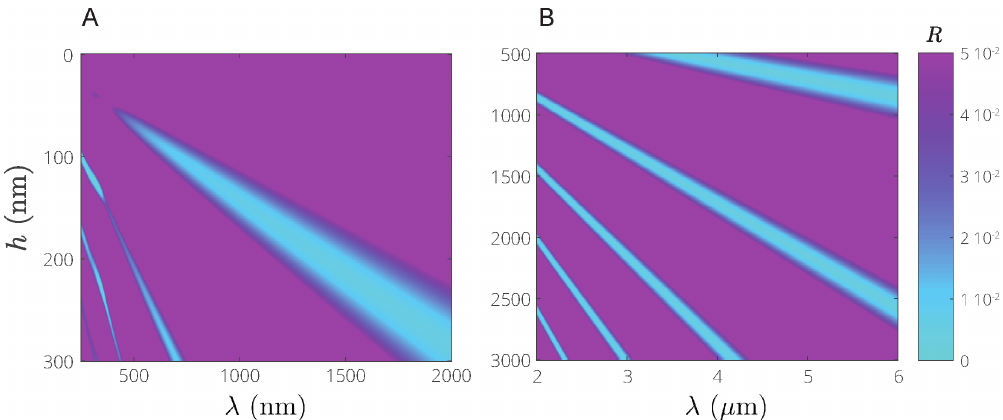
Figure 10. Reflectance R calculated for a nanoporous CeO 2 coatings of variable thickness h deposited on a silicon substrate. ( A ): Small thickness h in the visible and near-IR range; ( B ): Large thickness in the mid-IR range.